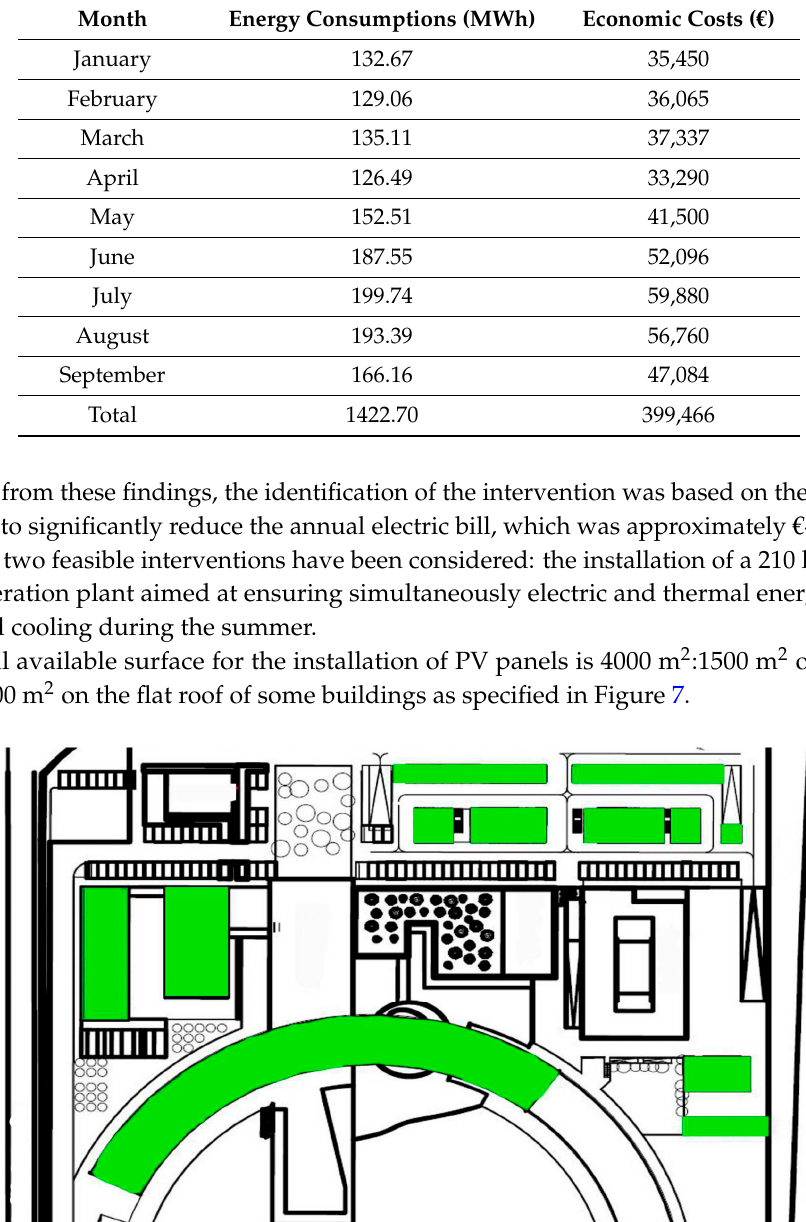
Figure 8. ASI trigeneration plant scheme. 2.5. Proposed Interventions: Ex Banco Napoli Due to the regulatory constraints of the building and its urban context, the only feasible intervention proposed for the reduction of energy consumption in the Ex Banco Napoli building concerns the installation of solar collectors on the roof, to reduce energy consumption for heating water. The system is schematized in Figure 9 and includes 12 solar thermal collectors of 2.070 m × 1.145 m with the following characteristics: antireflective treated glasses with high light transmission; a physical vapor deposition (PVD) highly selective and coated absorber for ensuring high energy absorption and low emissions; a hydraulic circuit with high heat transmission efficiency; a heat transfer fluid for heat absorption and transport; hydraulic connections to connect in series up to five thermal collectors (Table 10). The solar thermal collectors have been arranged avoiding the shading coming from existing plants in the building terrace and minimising the visual impact of the new system.